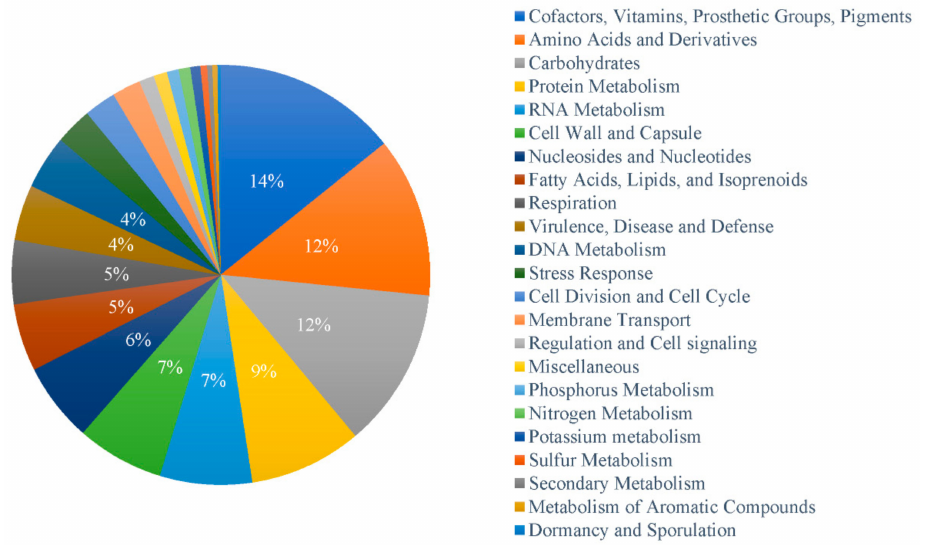
Figure 5. Functional distribution of genes that present in the genome of other Dyadobacter species that are missing in D. tibetensis